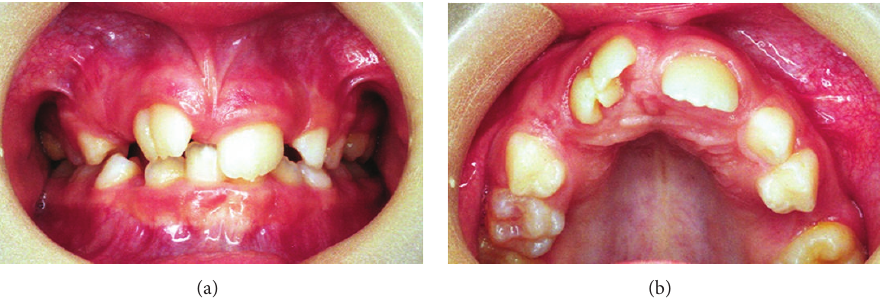
Figure 1: Clinical images of the fused right maxillary central incisor in eruption. Notice its broad crown with a talon cusp.